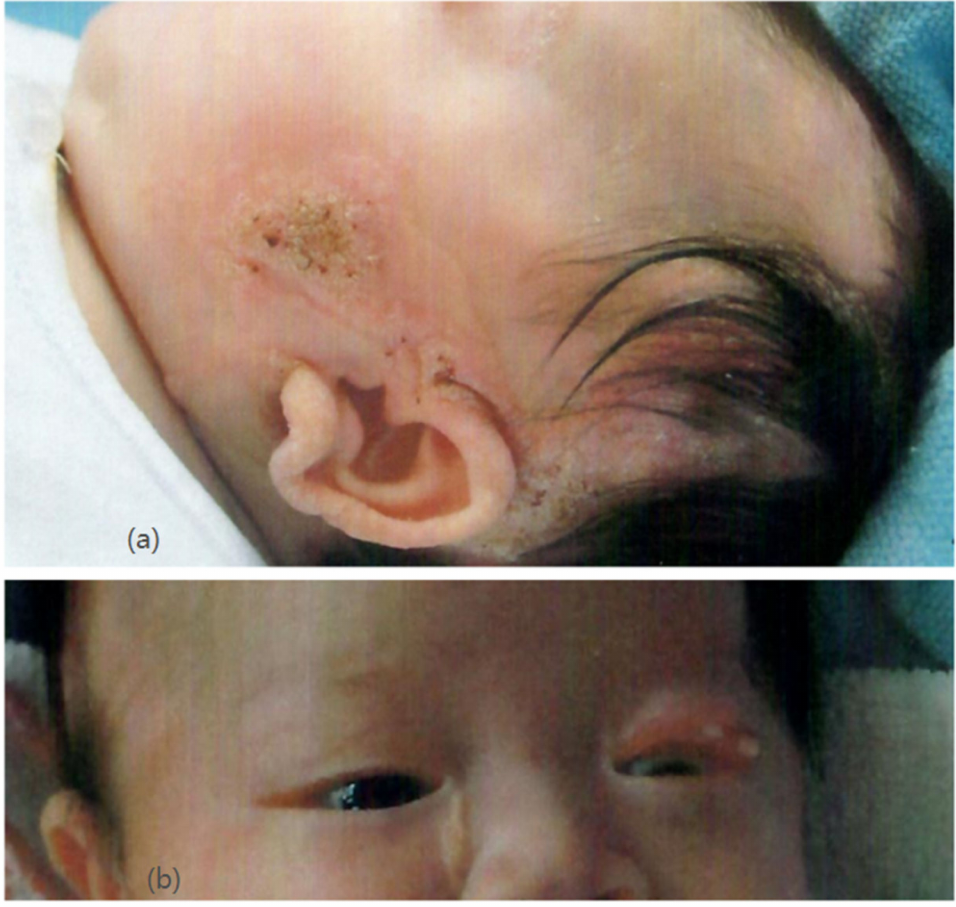
Figure 1. ( a ) (upper) Nevus sebaceous over the left face and scalp. ( b ) (lower) Lipodermoid at the left upper